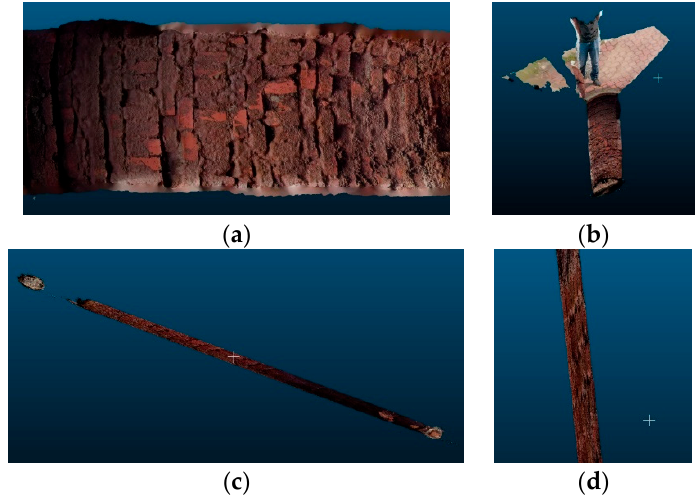
Figure 7. Reconstruction results based on side-view images ( a , b ), and reconstruction results based on front-view images ( c , d ).